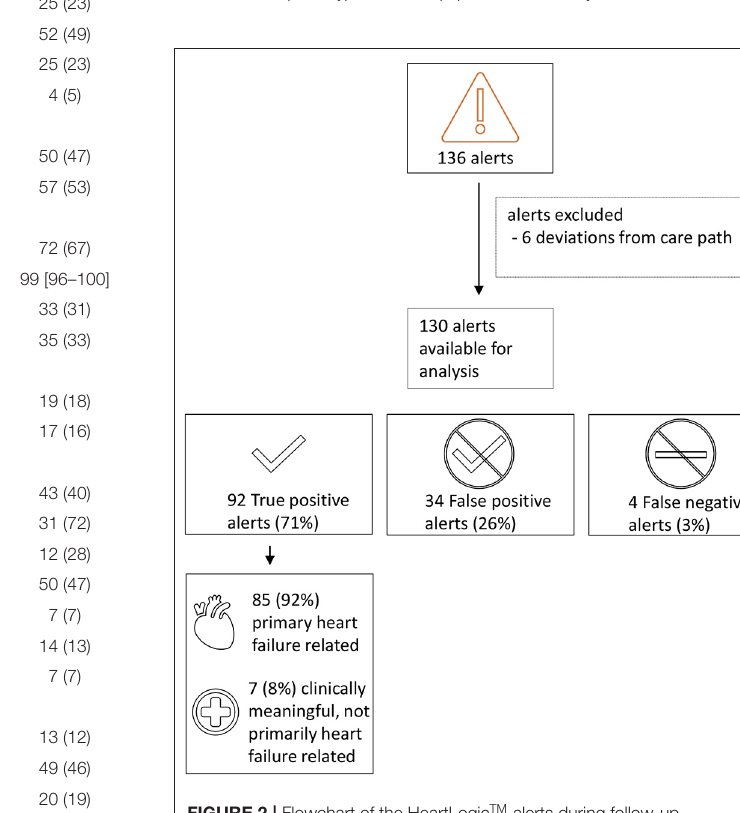
FIGURE 2 | Flowchart of the HeartLogic TM alerts during follow-up.